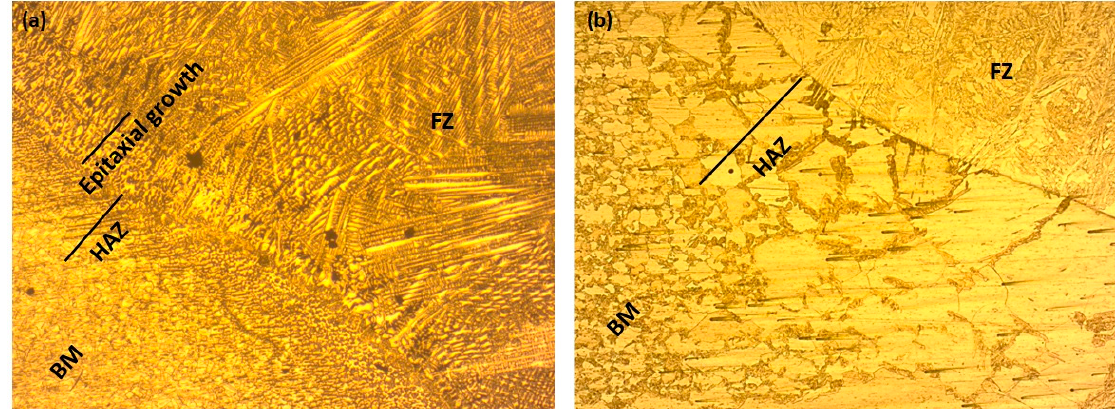
Figure 6. Microstructure of sample welded with ( a ) 310 ( b ) 410 filler.